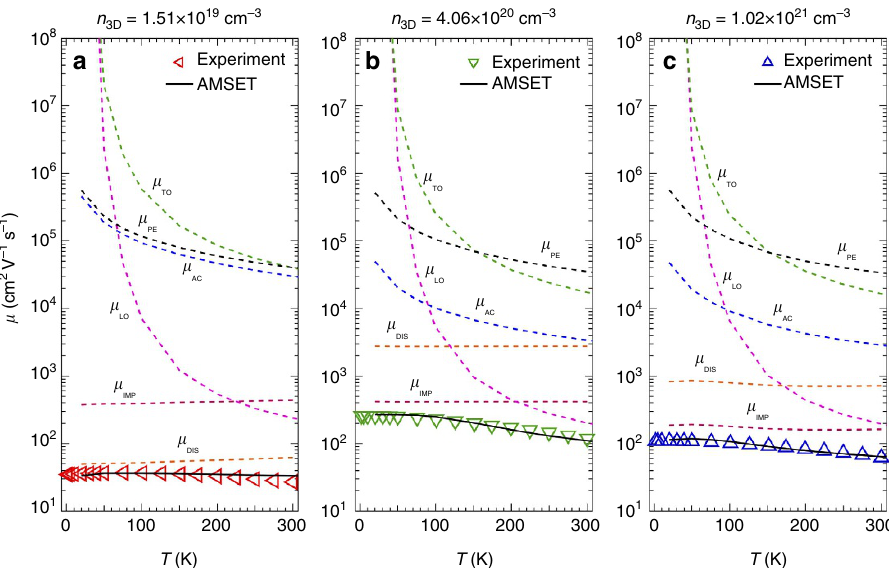
Figure 4 | Temperature dependence of mobility and individual contributions to the mobility from different scattering mechanisms. m versus T for doped BaSnO 3 films, ( a ) n 3D ¼ 1.51 (cid:3) 10 19 cm (cid:2) 3 , ( b ) n 3D ¼ 4.06 (cid:3) 10 20 cm (cid:2) 3 , and ( c ) n 3D ¼ 1.02 (cid:3) 10 21 cm (cid:2) 3 . Contributions from different carrier scattering mechanisms are shown with dotted curves. Dislocation density as calculated from the model were—( a ) Z D Z DIS N DIS ¼ 2.3 (cid:3) 10 12 cm (cid:2) 2 , ( b ) Z D Z DIS N DIS ¼ 7.0 (cid:3) 10 11 cm (cid:2) 2 , and ( c ) Z D Z DIS N DIS ¼ 2.8 (cid:3) 10 12 cm (cid:2) 2 respectively for the three samples, where Z D and Z DIS are the overall charge states of the donors and charged dislocations respectively. See method section for more